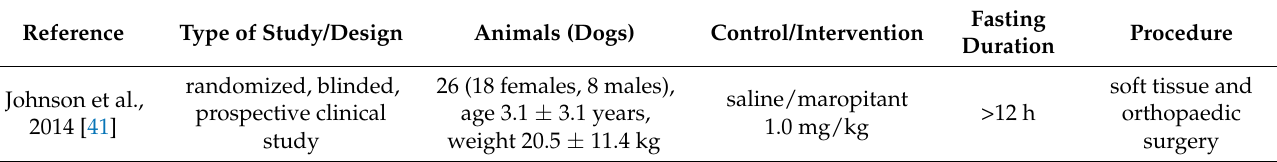
Table 7. Intervention: use of maropitant. Characteristics of the study in dogs.